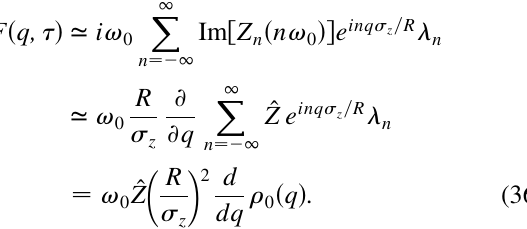
FIG. 5. Charge density of a Haı¨ssinski solution (solid line) for (cid:2) 0 : 844 pC = V ( h (cid:2) 1 cm and R (cid:2) 25 cm ). The normalized I c (cid:2) 0 : 9609 . The dashed line represents a rms bunch length is (cid:8) q Gaussian bunch with unity rms length. The impedance yields the complete longitudinal field, so that it contains a large space charge component at low frequencies when the beam has low energy.